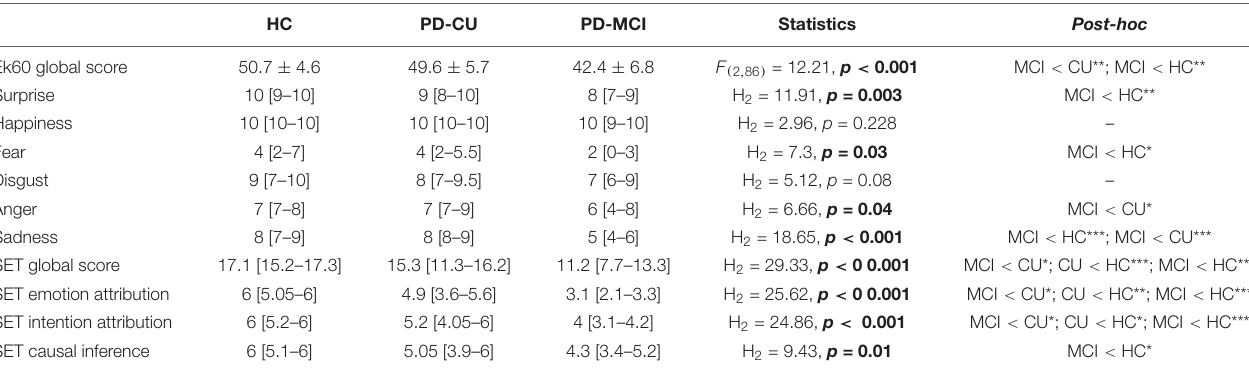
TABLE 3 | Performance comparison at social tasks between Parkinson’s disease (PD) patients characterized according to cognitive status and healthy controls